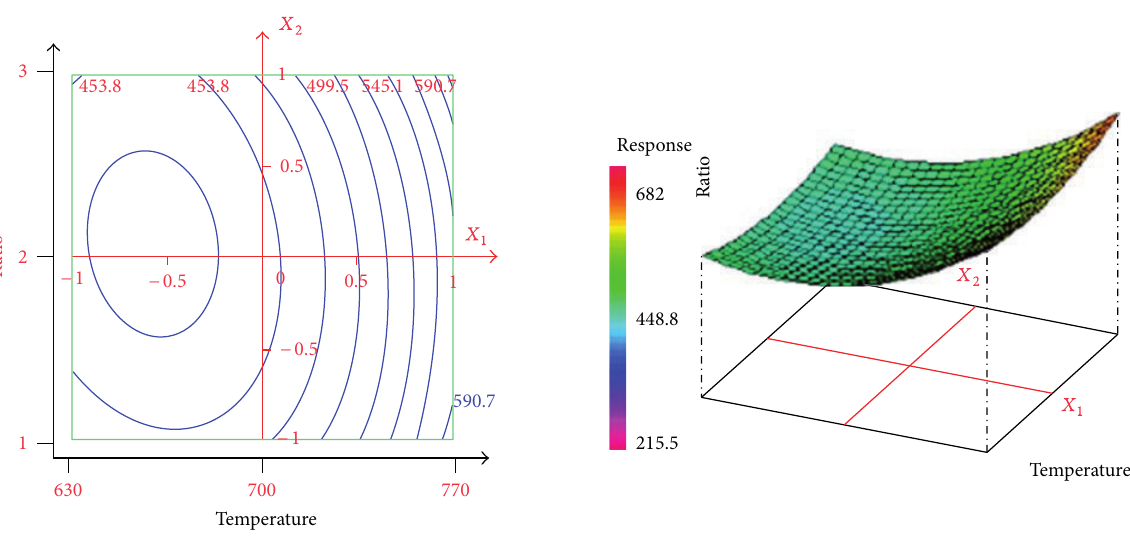
F 2: Variation of the iodine adsorption, I